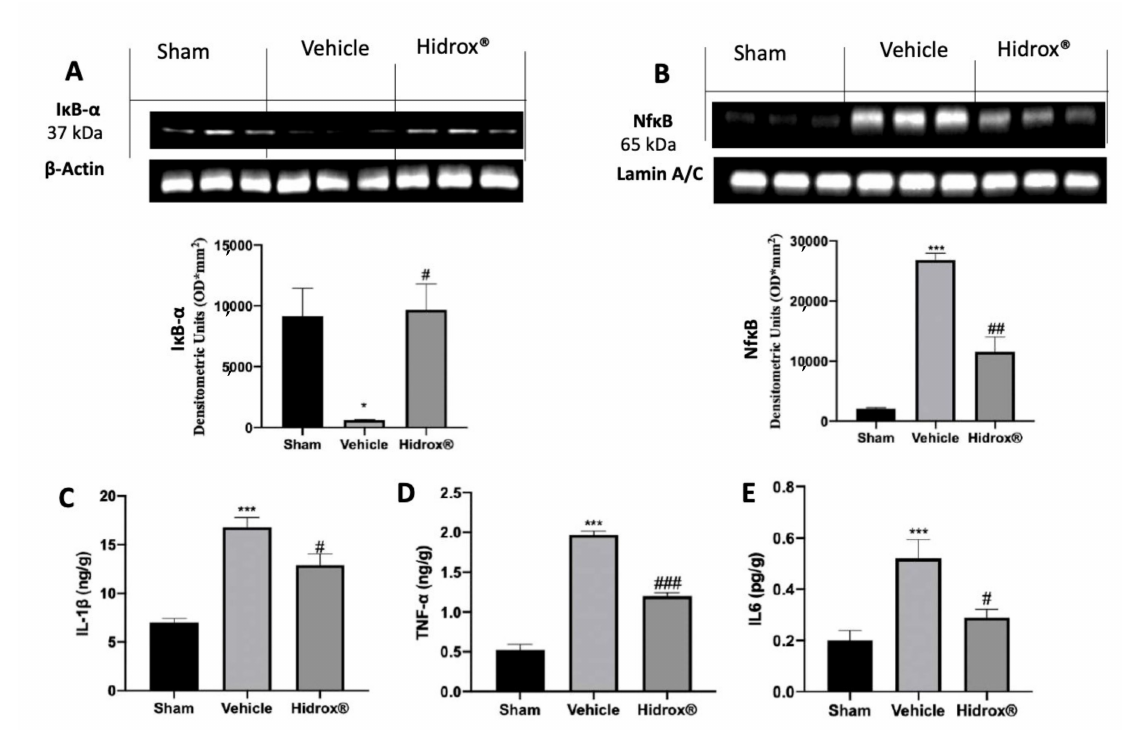
Figure 3. Hidrox ® administration reduced the levels of cytokines. Western blot analysis in whole brain of IkB- α ( A ) and NFkB ( B ) expressions, IL-1 β levels ( C ), TNF- α levels ( D ), IL6 levels ( E ). For the analyses, n = 5 animals in each group were employed. Results were analyzed by one-way ANOVA followed by a Bonferroni post-hoc test for multiple comparisons. Densitometric analysis of a representative western blot analysis of IkB- α expression ( A ): F (2,6) = 7.896, Densitometric analysis of a representative western blot analysis of NFkB expression ( B ): F (2,6) = 63.78, IL-1 β levels ( C ): F(2,12) = 14.83, TNF- α levels ( D ): F (2,12) = 92.69, IL6 levels ( E ): F(2,12) = 12.05. A p -value of less than 0.05 was considered significant. * p < 0.05 vs. sham, # p < 0.05 vs. vehicle, ## p < 0.01 vs. vehicle, *** p < 0.001 vs. sham, ### p < 0.001 vs.